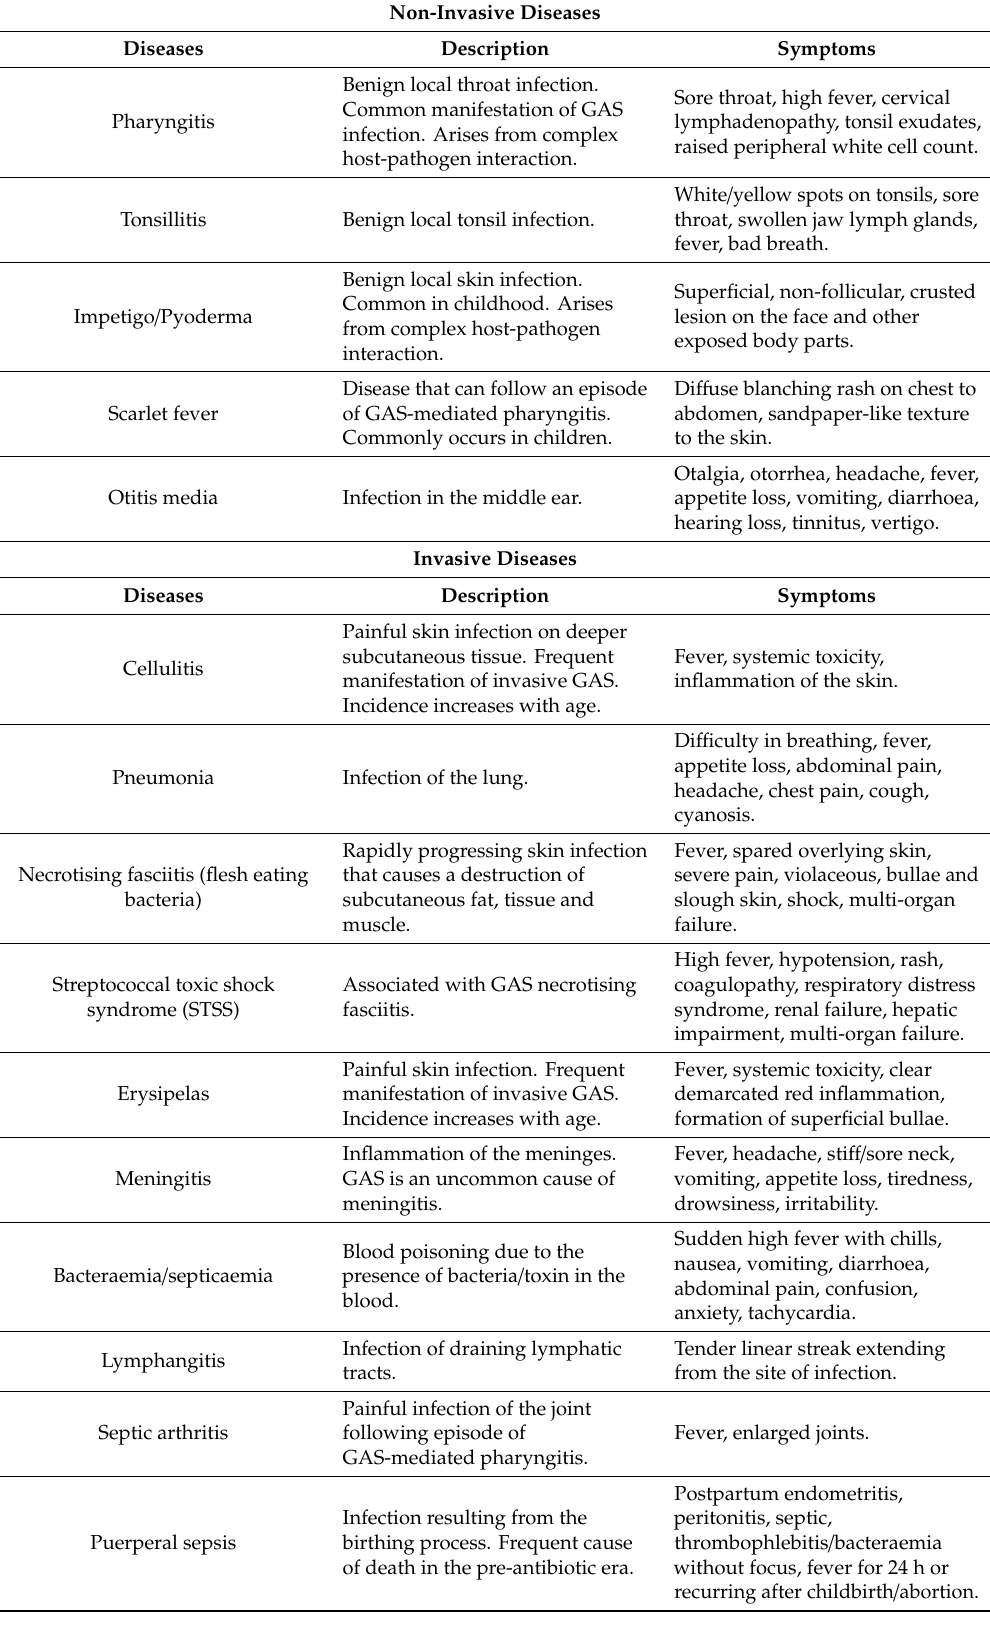
Table 1. Clinical manifestations of Group A Streptococcus infection